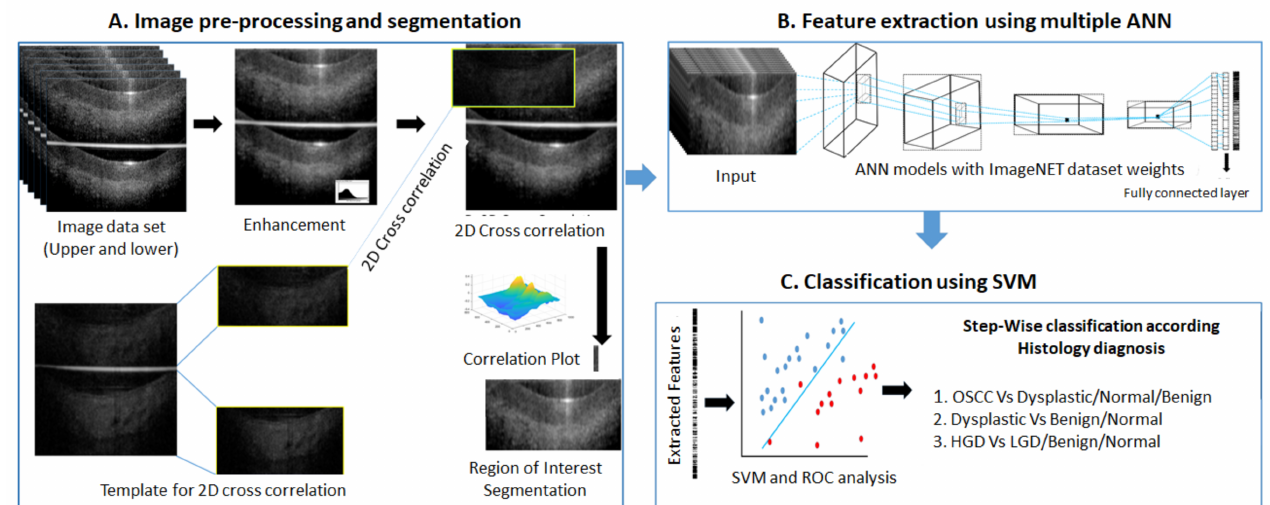
Figure 2. ANN-SVM based image analysis pipeline. Image data sets selected for image pre-processing and segmentation ( A ) after quality evaluation. The image was enhanced by Gaussian filter. Template images were used to segment region of interest of upper and lower sections by 2D-cross correlation. Feature extraction ( B ) was performed on segmented images by multiple artificial neural networks (ANN). The extracted features were used for developing Support Vector Machine model (SVM) model for each ANN feature vectors ( C ). The receiver operating characteristic (ROC) curve analysis was performed in cross-validation data set to find out optimal cut-off score for classification. The SVM-model validated in test data set and classified according cut-off score. The ANN-SVM models were developed for stepwise classification- initially for classifying OSCC from dysplastic/normal/benign lesions and then dysplastic from benign/normal lesions. OSCC: Oral squamous cell carcinoma, HGD: High grade dysplasia–Moderate/Severe dysplasia, LGD: Low grade dysplasia- Mild dysplasia, hyperplasia, ANN: Artificial neural network, 2D- 2 dimensional, SVM: Support vector machine, ROC: Receiver Operating